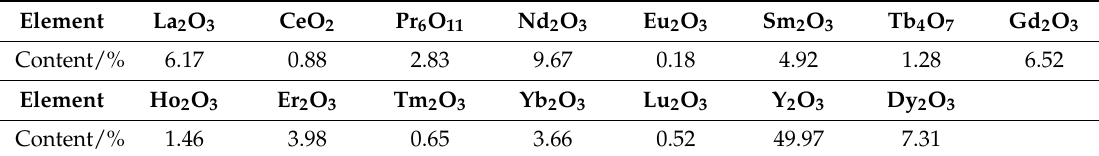
Table 4. The partitioning of the exchangeable rare earth (RE) of rare earth ore (wt